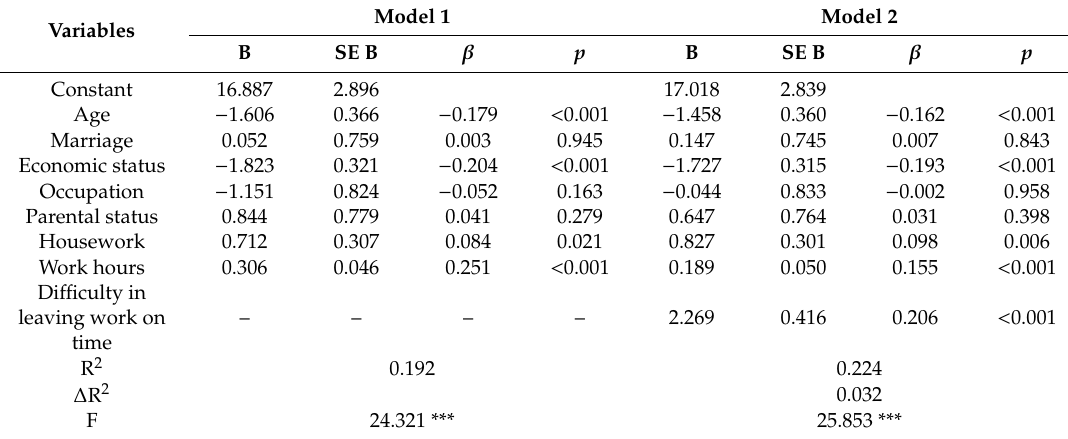
Table 4. Multiple regression for